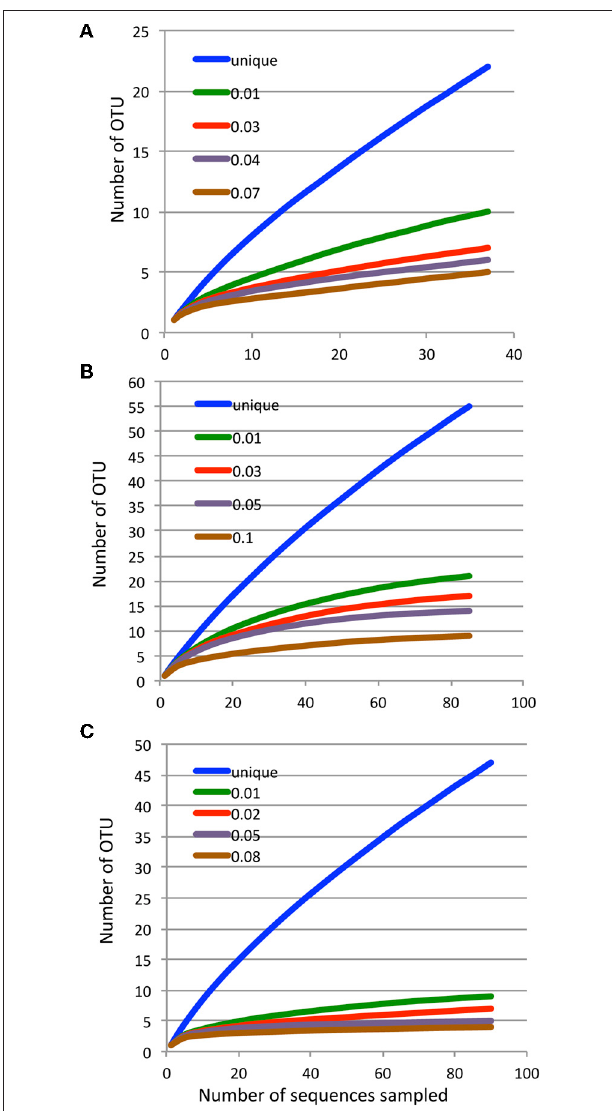
FIGURE 4 | Rarefaction analyses of the archaeal amoA libraries from the rice (Panel A), bagasse (Panel C) and coffee (Panel C) composts. For the bagasse and rice composts, cow- and sheep-manure treatments were pooled. Each curve illustrates the cumulative OTU number at the indicated phylogenetic